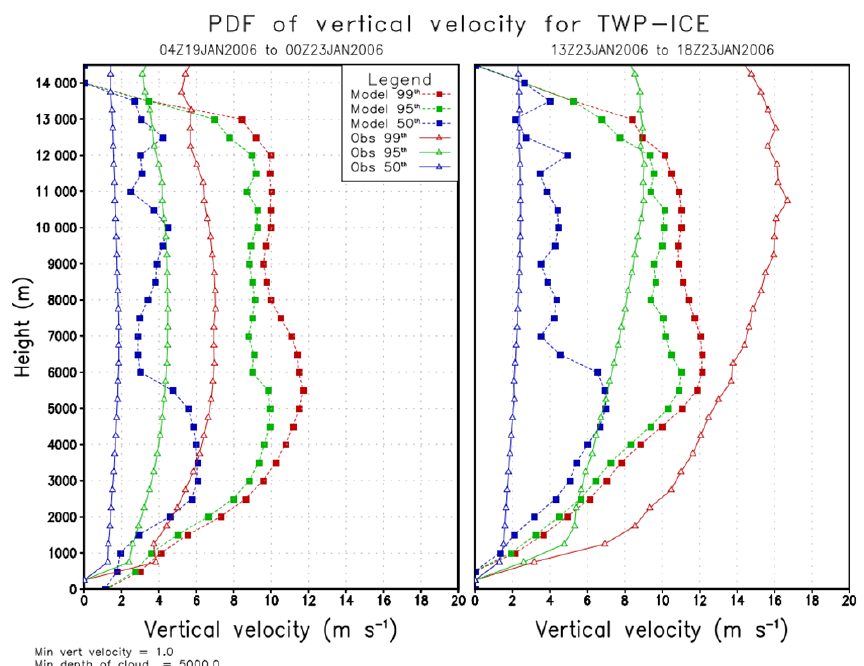
Figure 5. Probability distribution functions of vertical velocities in deep convective updrafts using the cumulus parameterization in Donner et al. (2011) and observed using dual-Doppler radar (Collis et al., 2013; Varble et al., 2014). The panels show two periods (04:00UTC, 19 January to 00:00UTC, 23 January 2006 and 13:00 to 18:00UTC, 23 January 2006) for which radar observations are available, along with model-generated updrafts for the same periods. Both panels show radar-observed and model-generated updrafts whose vertical extent is at least 5km with a minimum speed of 1ms − 1 or larger. The percentiles (colors) are the fraction of the updrafts with vertical velocities less than the plotted velocities, as functions of